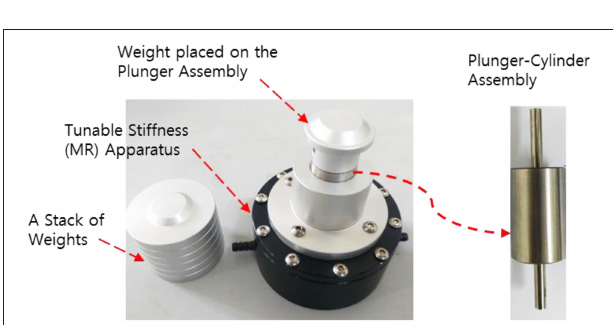
FIGURE 5 | Frictionless plunger used in the experimental setup. Applanation force or “hold-down pressure” is varied by adjusting the weights atop the cylinder with a frictionless